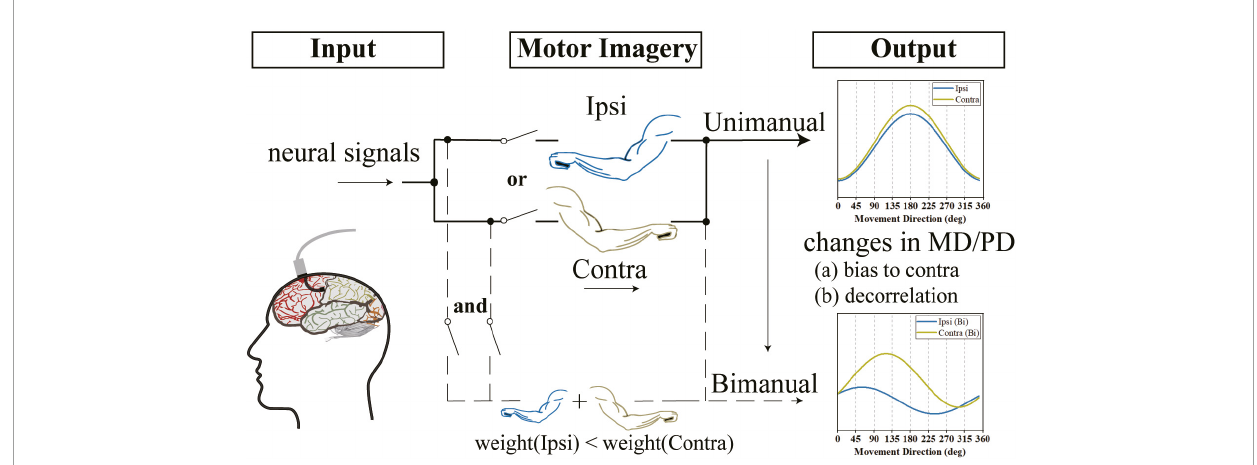
FIGURE9 We observed that the outputs of the M1 area were not lateralized when using either arm and the directional tunings for ipsilateral and contralateral arms were highly correlated. However, when switching to bimanual movements, there was a decorrelation process and the outputs were biased to the contralateral side. We speculate that the changes in the bimanual relationship can be attributed to the alternation of tuning parameters, such as the increased (cid:49) PD contributed by both the ipsilateral and contralateral sides and the significant suppression in bilateral MDs, especially the ipsilateral